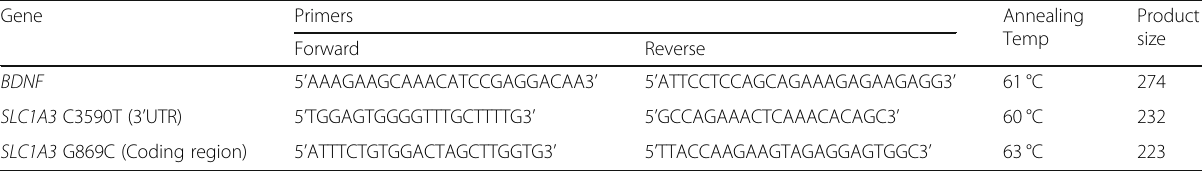
Table 1 Primers used for detecting SNPs in BDNF and SLC1A3 gene with optimized temperatures and product size Gene